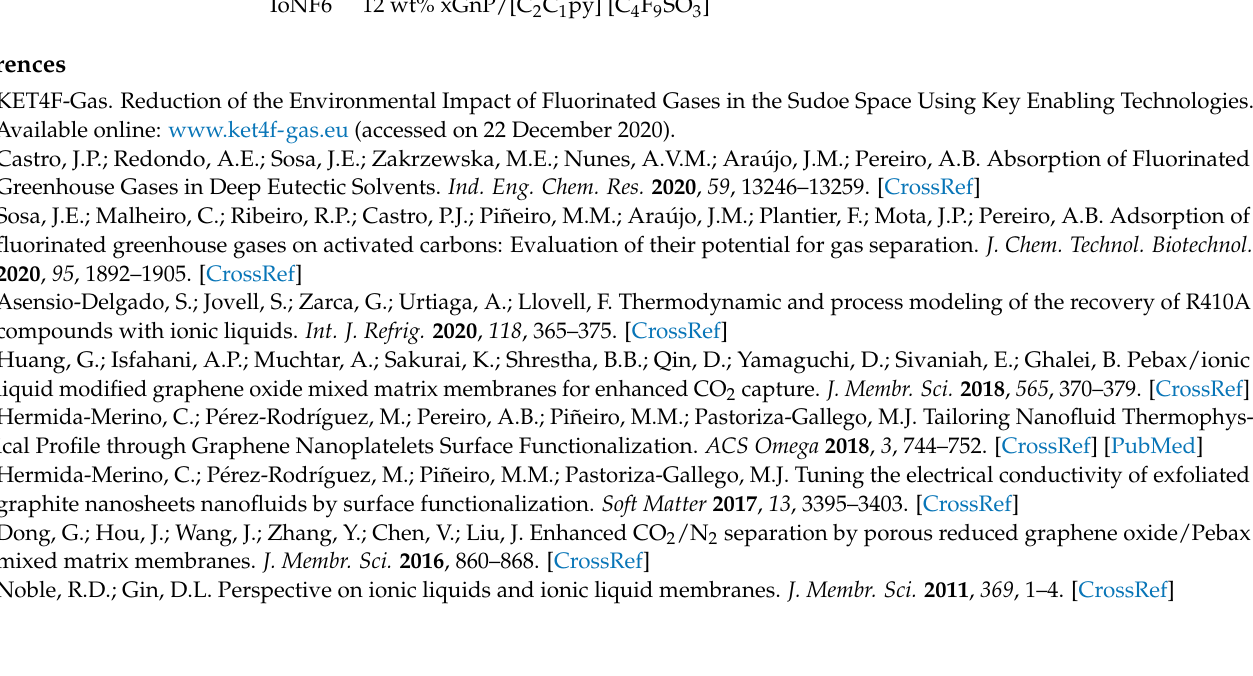
Figure S6. DSC Termograms of IL, Pebax, Pebax/20IL, Pebax/40IL, Pebax/60IL, Pebax/19.8/IL/ 0.2xGnP, Pebax/18IL/2xGnP, Pebax/16IL/4xGnP, and Pebax/32/8xGnP at 10 ◦ C/min: (a) cool- ing ramp, (b) heating ramp, Figure S7. STEM images of Pebax, Pebax/20IL, Pebax/40IL, Pe- bax/60IL, Pebax/19.8IL/0.2xGnP, Pebax/18IL/2xGnP, Pebax/16IL/4xGnP, Pebax/32IL/8xGnP, and Pebax/48IL/12xGnP (full names in Table 1), Figure S8. 2D imaging with optical reflection of Rough face A and face B of Pebax, Pebax/20IL, Pebax/40IL, Pebax/60IL, Pebax/19.8IL/0.2xGnP, Pebax/18IL/2xGnP, Pebax/16IL/4xGnP, Pebax/32IL/8xGnP, and Pebax/48IL/12xGnP (full names in Table 1), Figure S9. 3D imaging with topographic enhancement of Rough face and Smooth face of Pebax, Pebax/20IL, Pebax/40IL, Pebax/60IL, Pebax/19.8IL/0.2xGnP, Pebax/18IL/2xGnP, Pe- bax/16IL/4xGnP, Pebax/32IL/8xGnP, and Pebax/48IL/12xGnP (full names in Table 1). Table S1. Identification of bands corresponding to the graphene [S1-S3], Table S2. Identification of bands corresponding to the ionic liquid [S4,S5], Table S3. Identification of bands corre-sponding to Pe- bax®1657